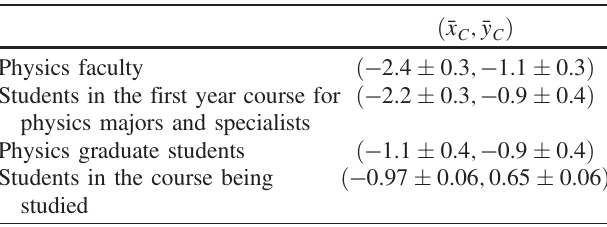
TABLE IV. Mean centroid values.